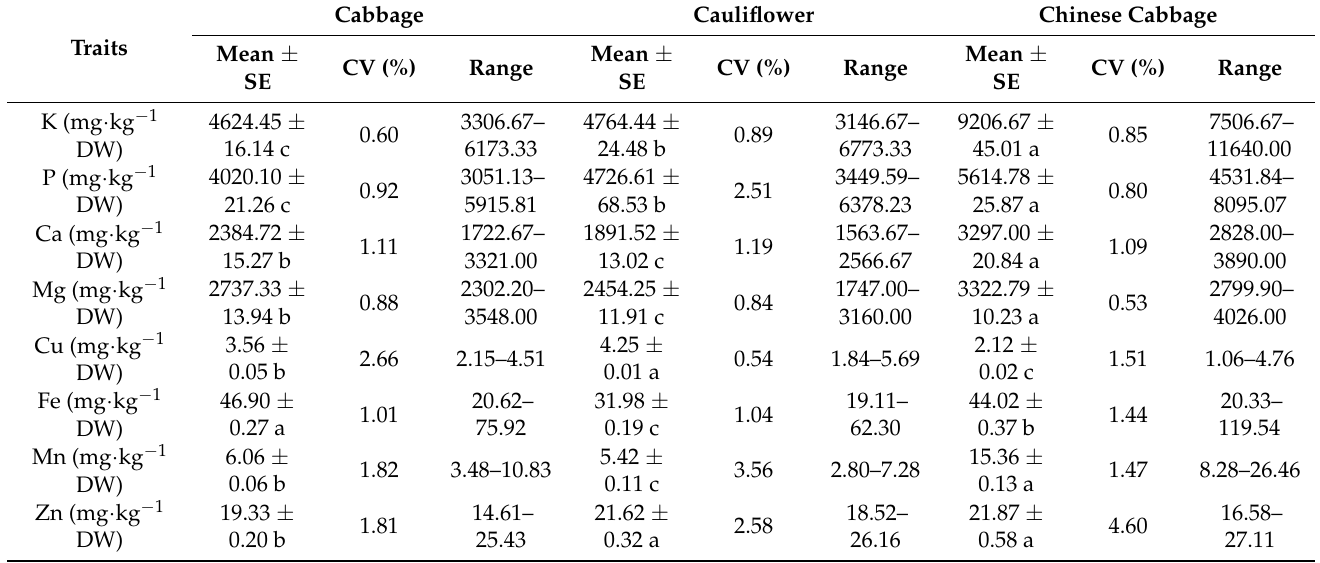
Table 6. Mean ± standard error (SE), range, and coefficients of variation (CVs) for the mineral elements in the species analyzed. Species means with different letters are significantly different at p ≤